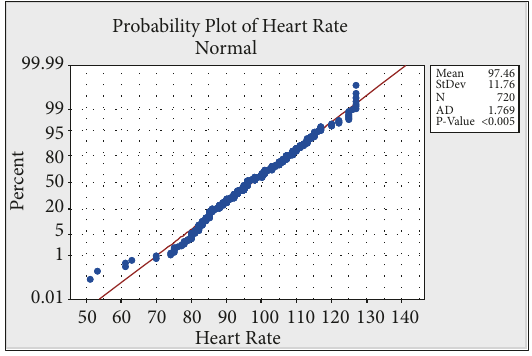
Figure 1: ANOVA test of the residuals during the heart rate study.